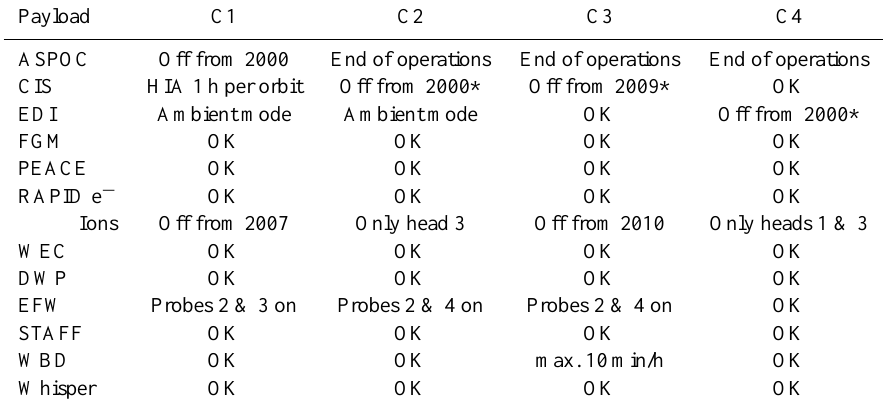
Table 4. Status of Cluster payload as of 2013.